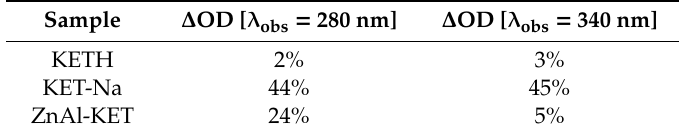
Table 1. ∆ OD measured at di ff erent λ obs upon 2 h irradiation of the samples at 330 nm.